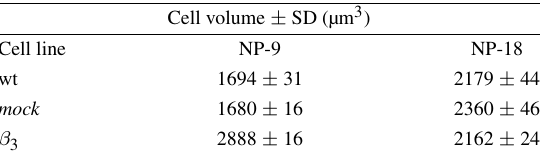
Effects of β 3 overexpression on cell